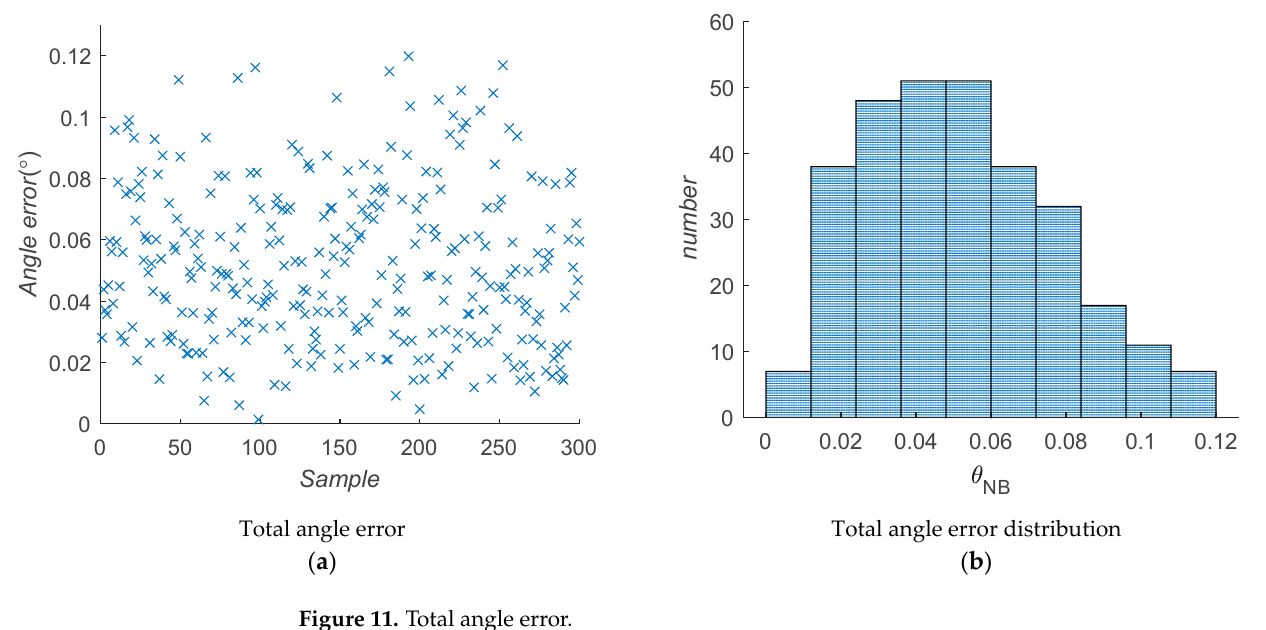
Figure 11. Total angle error.